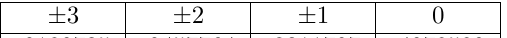
Table 5: Probability distribution of ab + b 0 ( a + a 0 ), where a , b , a 0 , b 0 ← β 2 ± 3 ± 2 ± 1 0 .